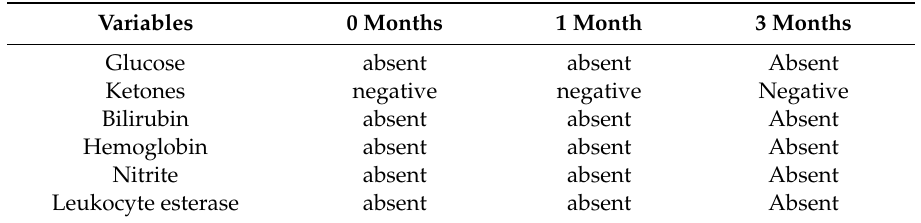
Table 4. Evaluation of urinary